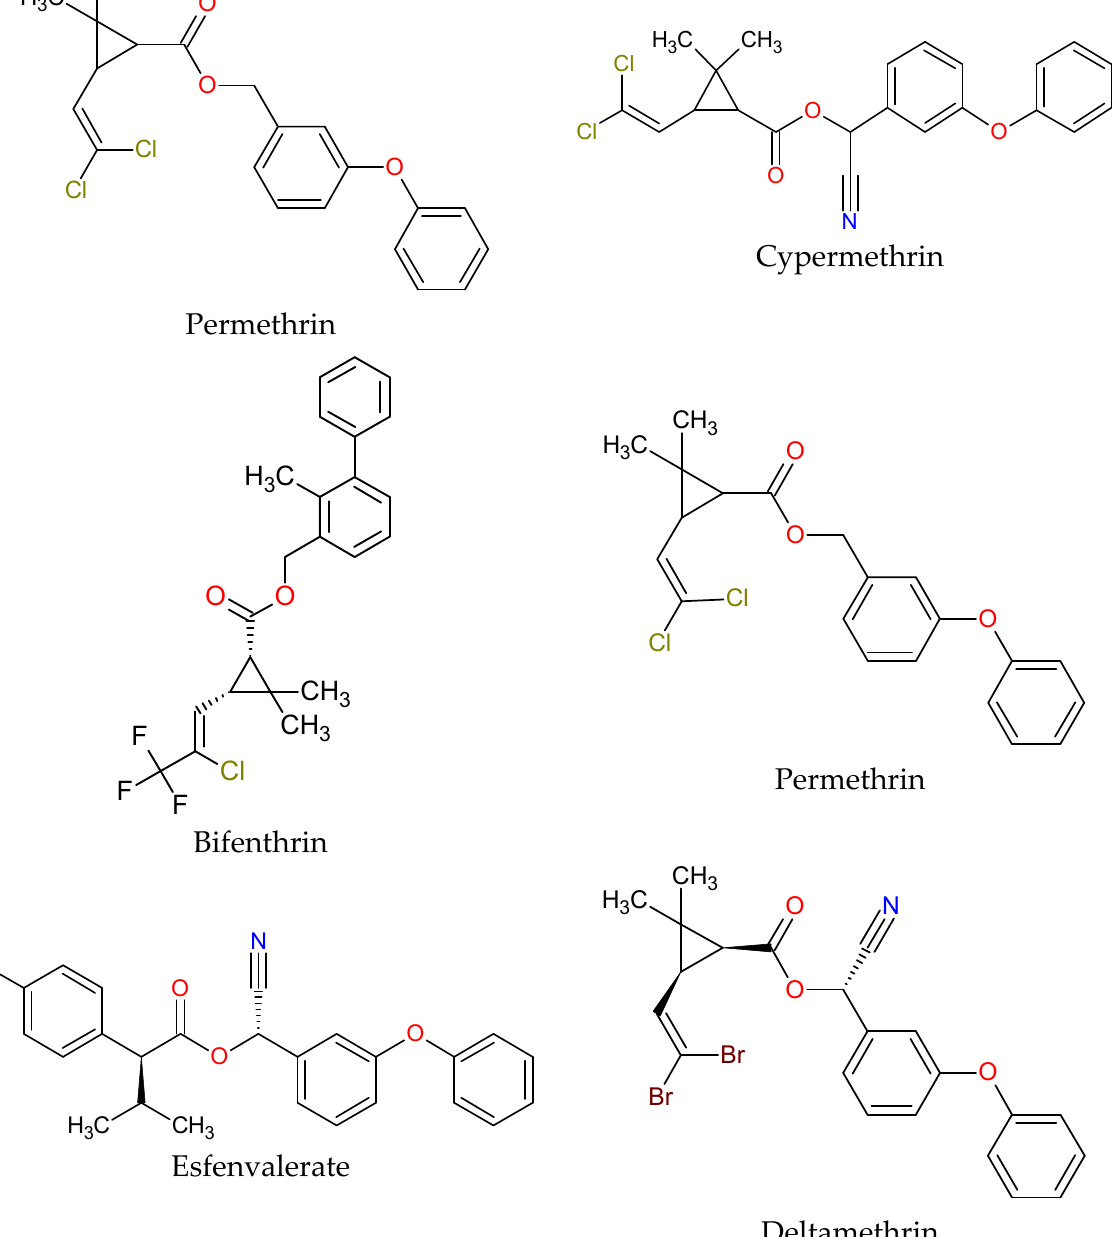
Figure 4. Structural formula of the main pyrethroids.